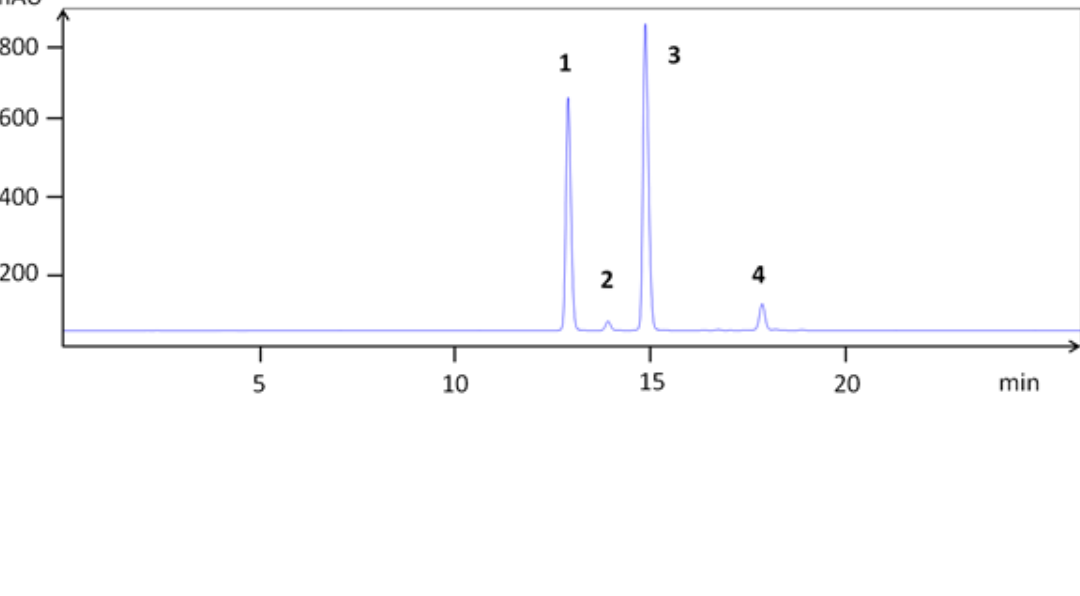
Figure 1. High-performance liquid chromatography (HPLC) chromatogram of the isolated anthocyanins: cyanidin 3-galactoside ( 1 ), cyanidin 3-glucoside ( 2 ), cyanidin 3-arabinoside ( 3 ) and cyanidin 3-xyloside ( 4